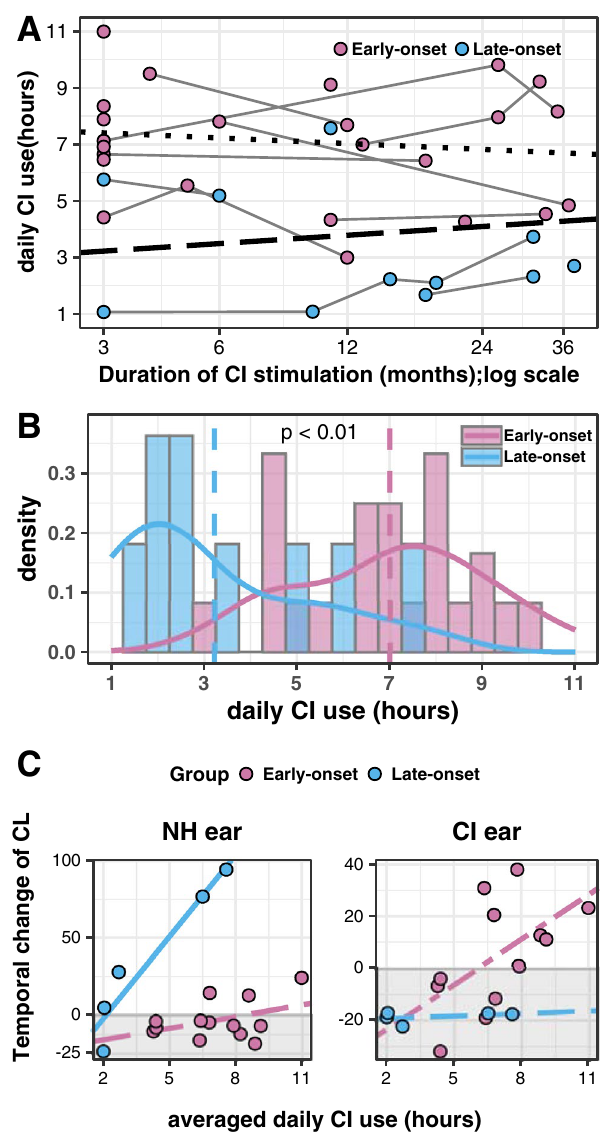
Figure 5. Daily hours of CI use and effects on cortical lateralization. (A) Average daily hours of device use with chronic CI use (≥ 3 month) is plotted over time of CI use for each child (14 with early-onset and 5 with late-onset) at each recording time. There is high variability and no significant change over time (p > 0.05). (B) The distribution of hours of daily CI use are shown for each group. Average daily CI use was significantly reduced in the late-onset group (p < 0.01). C) The changes of lateralization by the time of CI experience (slopes for individual child from Fig. 4A) was plotted as a function of averaged daily hour of device use. Increased daily device use promotes expected changes toward contralateral lateralization to the NH stimulation in the late-onset group (p = 0.01) and to the CI stimulation in the early-onset group (p =